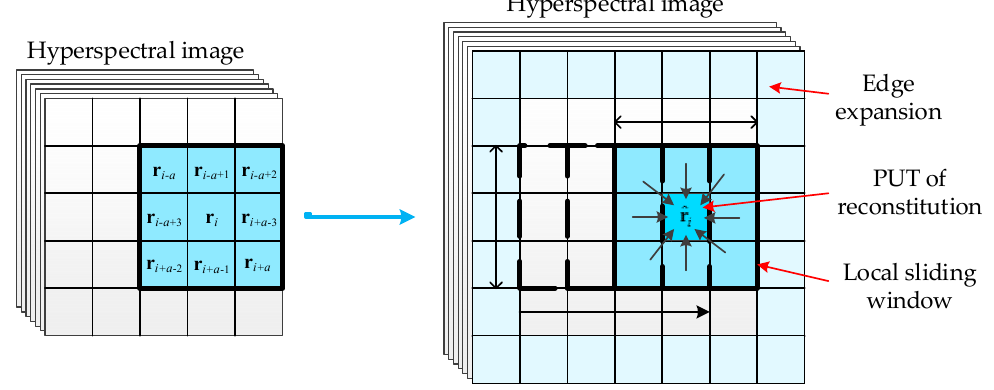
Figure 3. Illustration of information reconstitution.